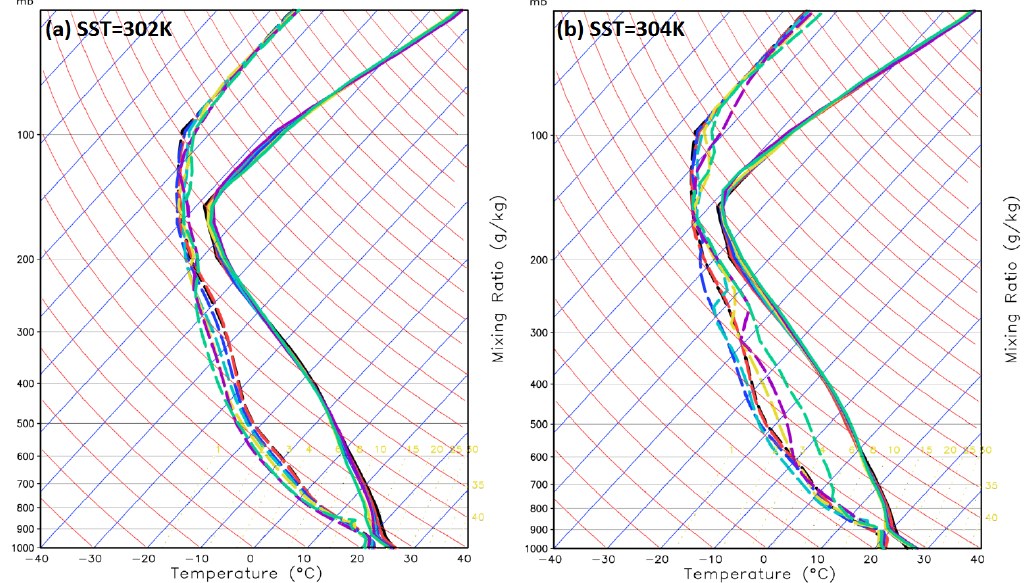
Figure A1. Area-averaged soundings within a radius of 1000 km from the model storm center that are obtained from HWRF model with the August mean sounding in the WPAC basin, valid at t = 0 h (black), t = 12 h (cyan), t = 24 h (blue), t = 36 h (purple), t = 48 h (brown), and t = 72 h (green) in two experiments with ( a ) SST = 302 K, and ( b ) SST = 304 K. Solid (dashed) lines denote the temperature (dewpoint)